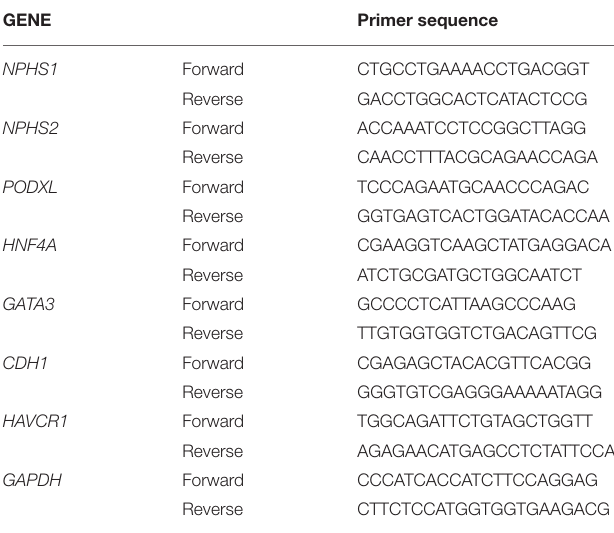
TABLE 1 | Primers used for quantitative real-time PCR analysis of human kidney